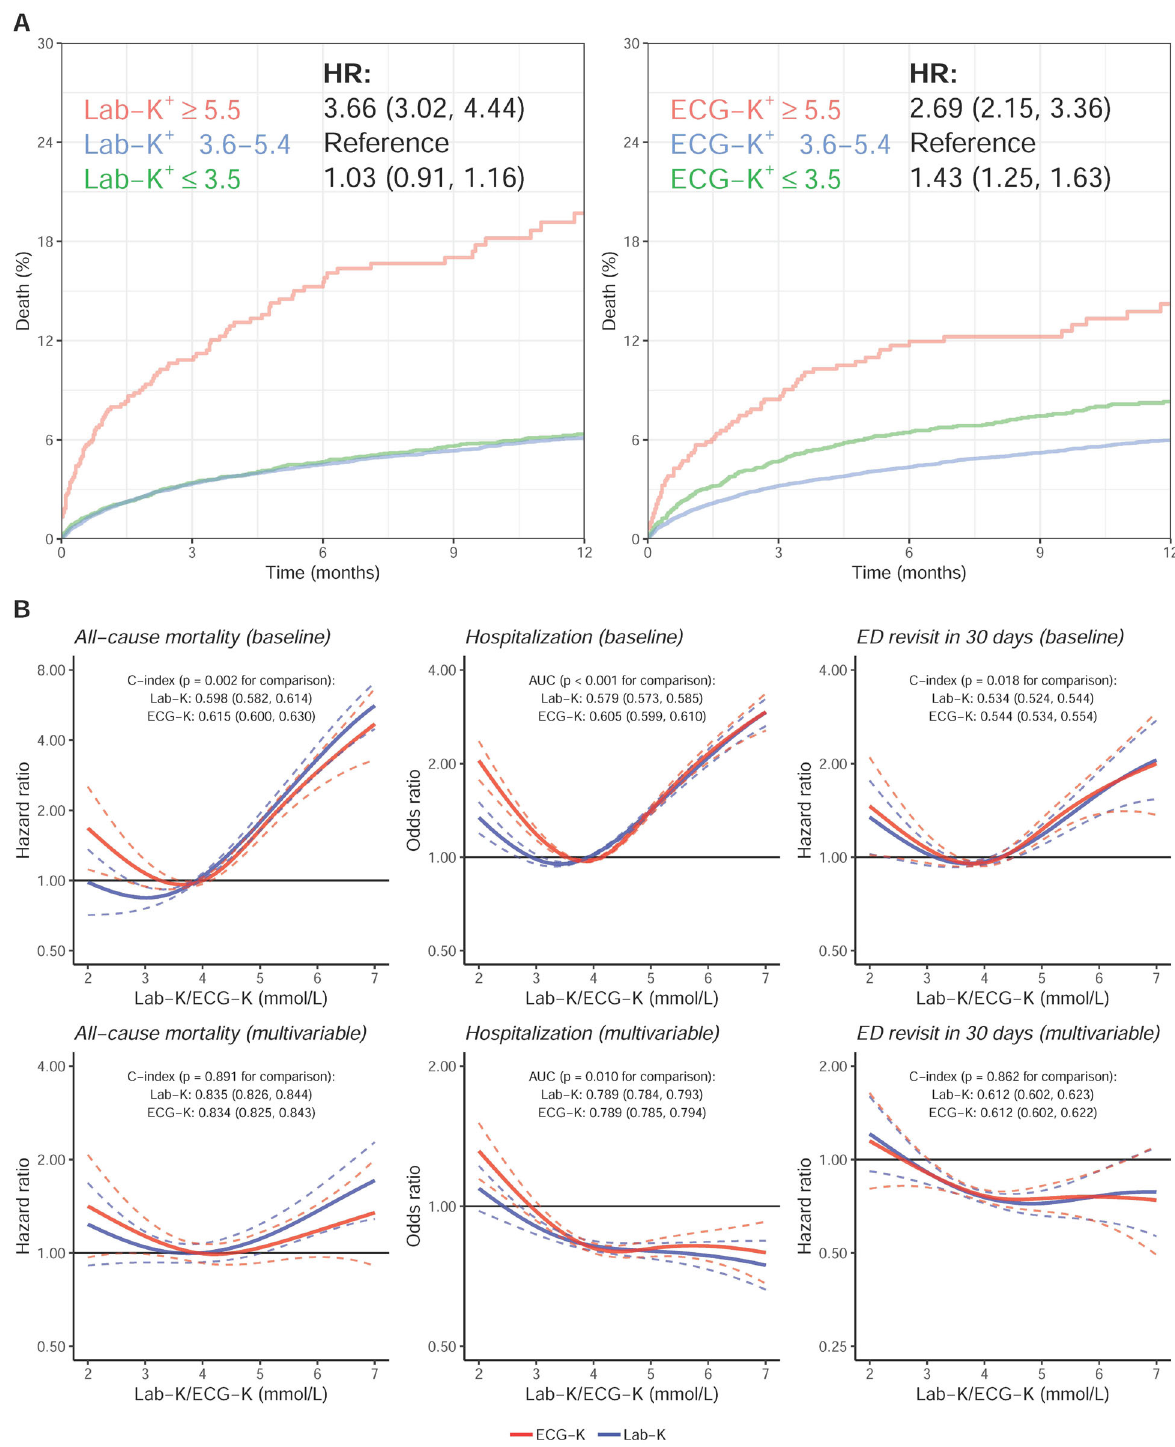
Fig. 4 The relationship between ECG-K + and Lab-K + on adverse outcomes in combined analysis from both hospitals. A The Kaplan – Meier curve analysis of all-cause mortality in hypo- and hyperkalemia as de fi ned by ECG-K + and Lab-K + . The hazard ratio (HR) was adjusted by hospital site; ( B ) Continuous association of ECG-K + and Lab-K + on adverse outcomes. The solid line and dashed line are point estimation and corresponding 95% conference interval, respectively. The baseline model of combined analysis is adjusted to each hospital site and based on Cox proportional hazard model or logistic regression as appropriate for each outcome. The multivariable analyses include signi fi cant variables in risk-effect analyses (All-cause mortality: gender, Age, SBP, DBP, HLP, Hb, HCO 3 , Blood pH, Na, AST, ALT, Alb, CRP, pBNP, and D-dimer; Hospitalization: gender, age, BMI, DBP, smoke, HLP, STK, HF, WBC, Hb, PLT, HCO 3 , PH, Na, Cl, tCa, GLU, AST, CK, Alb, CRP, TnI, and D-dimer; ED revisits in 30 days: gender, DM, CAD, STK, COPD, Hb, and